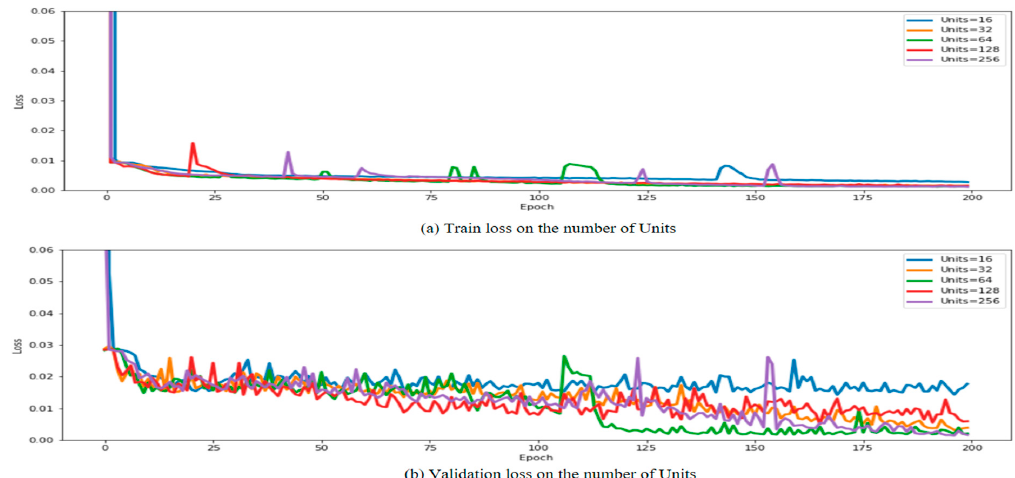
Figure 11. Train and validation loss values according to the number of units. ( a ) Train loss on the number of units; ( b ) validation loss on the number of units.